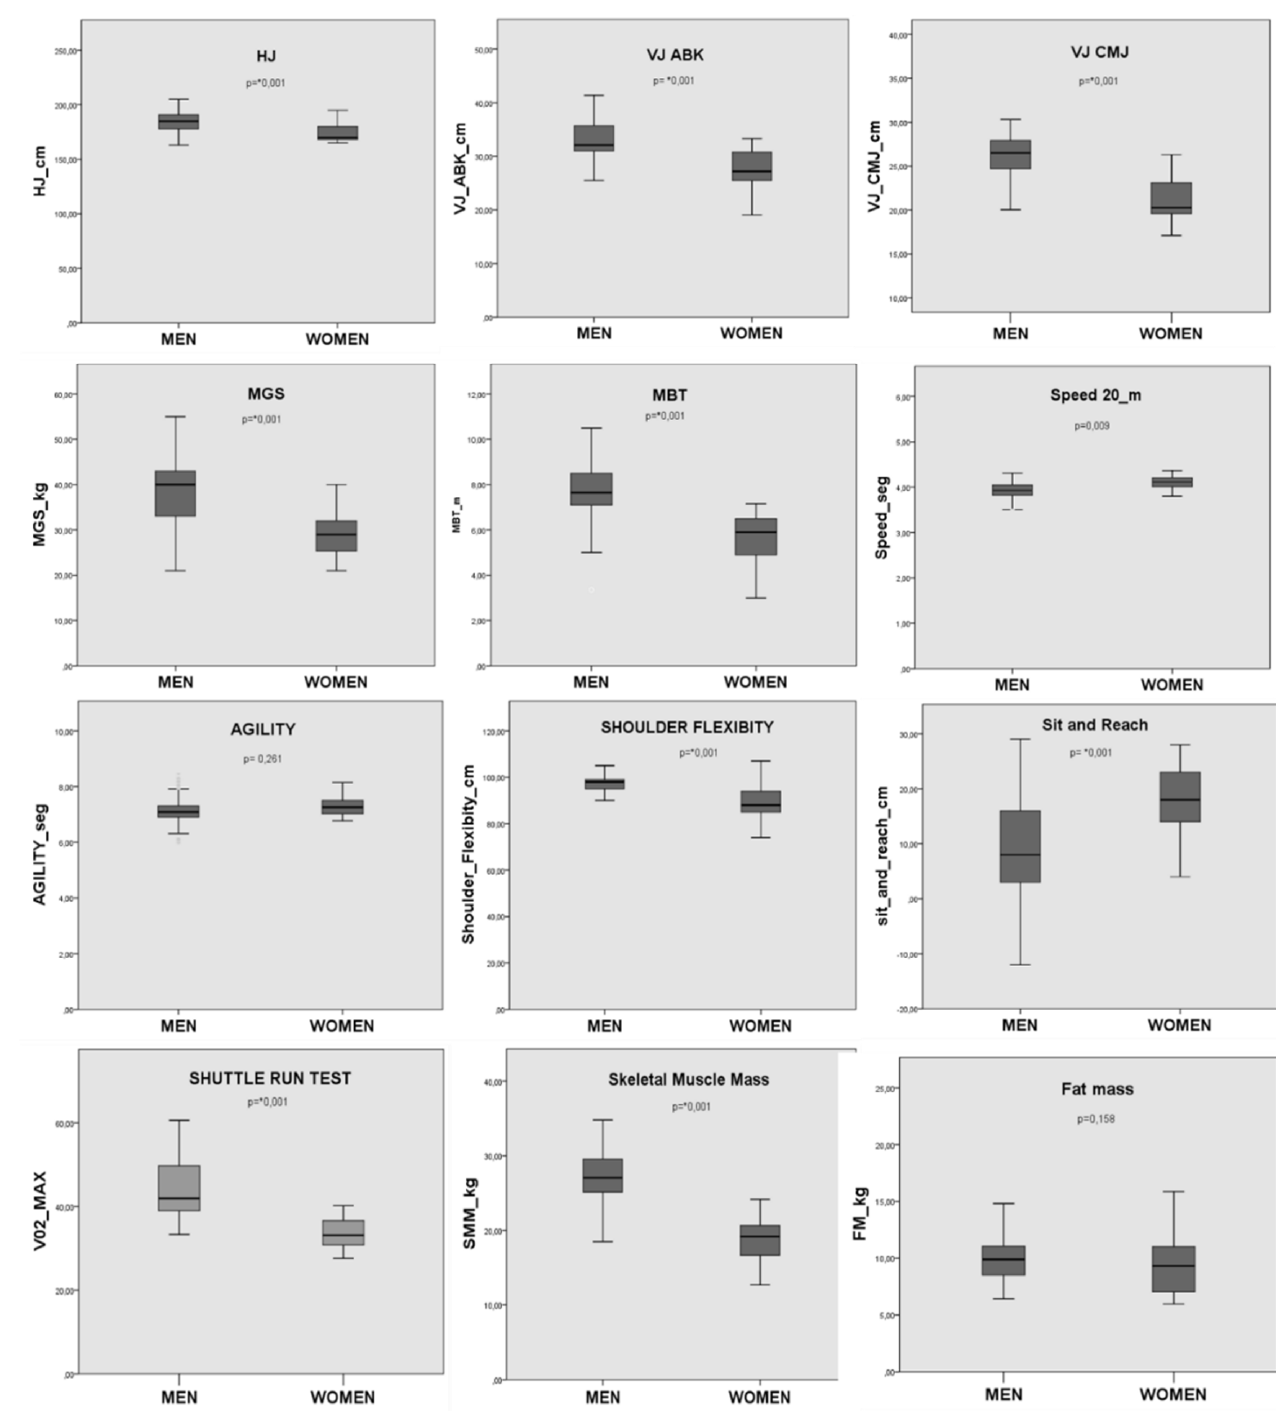
Figure 1. Comparison of mean and standard deviation in measures of physical performance and body composition (*: significant